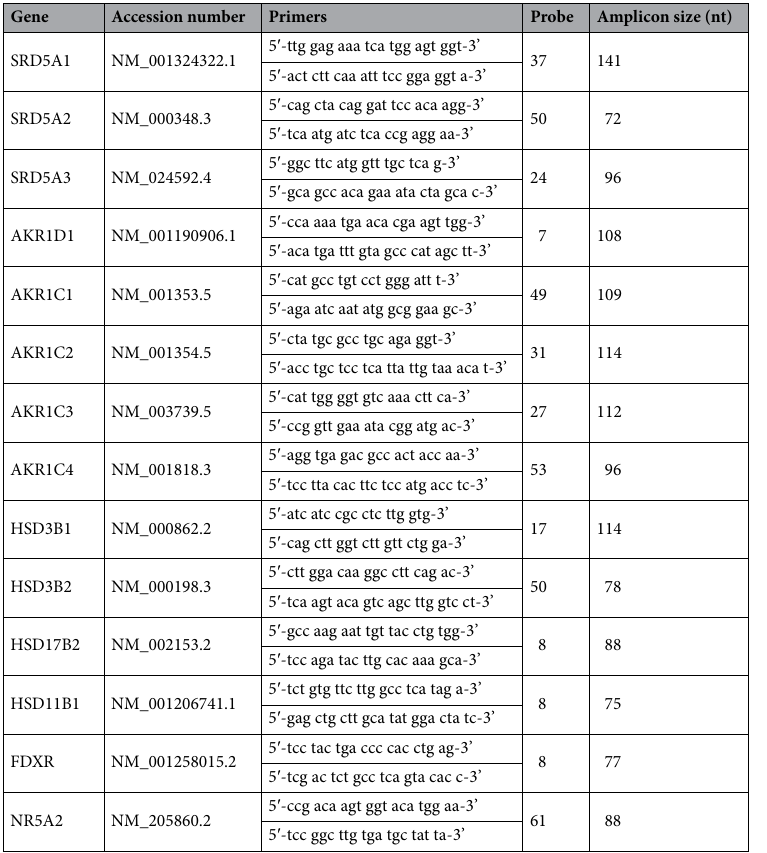
Table 1. Human primers and probes used in Real-time PCR.